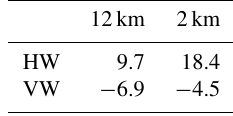
Table 2. Relative changes in total accumulated precipitation with surrogate warming compared to control in %. The calculations con- sider spatial means over the analysis domain accumulated for 3– 13 June